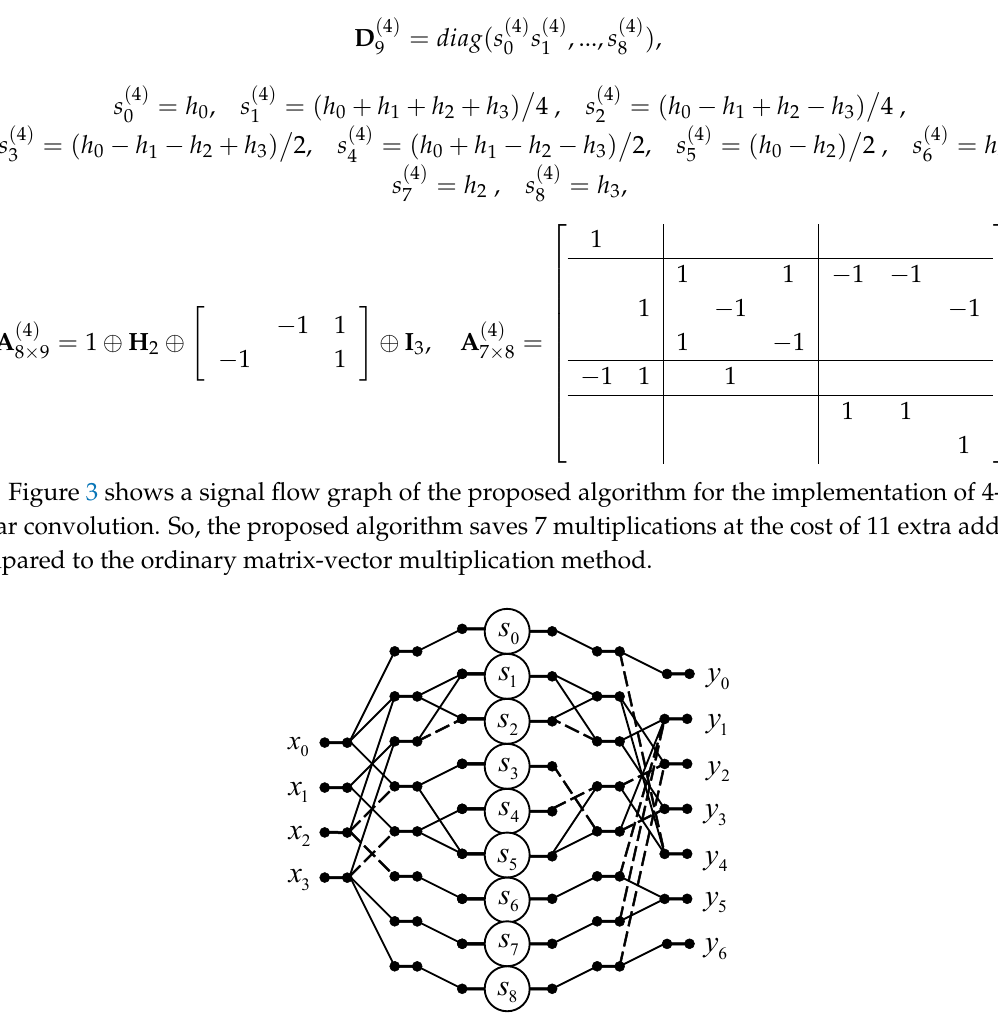
Figure 3. The signal flow graph of the proposed algorithm for computation of 4-point linear